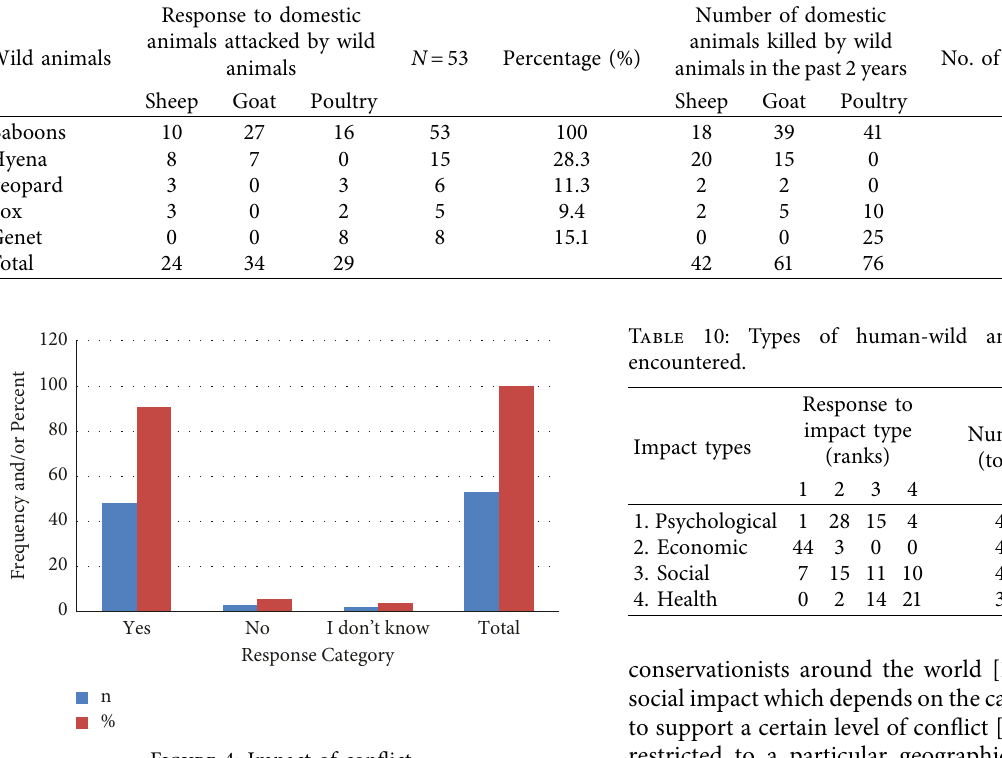
Figure 4: Impact of conflict.